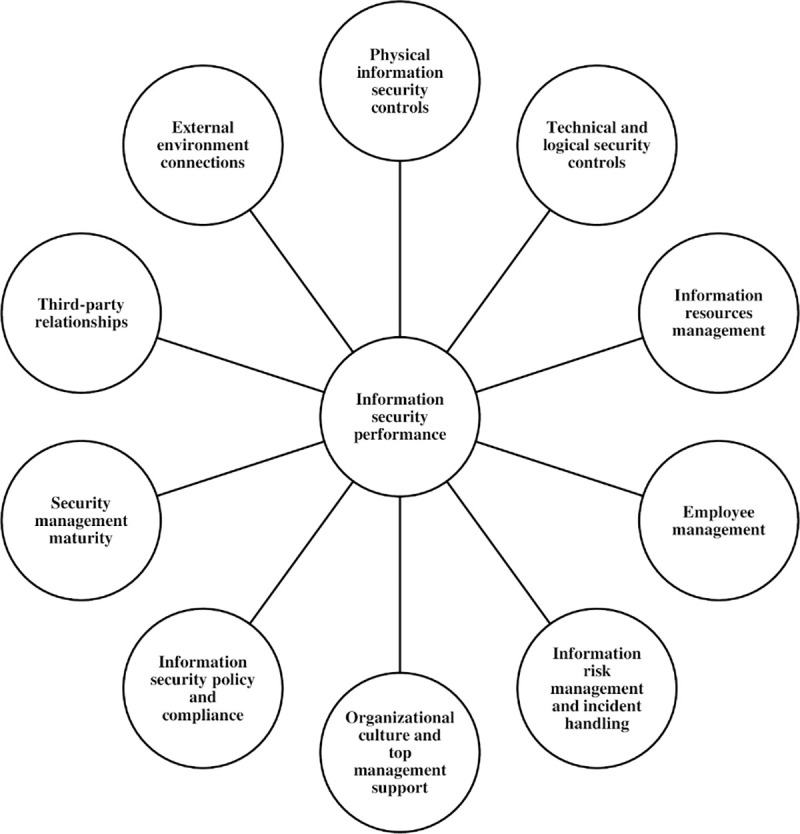
The ISP 10×10M model [40].